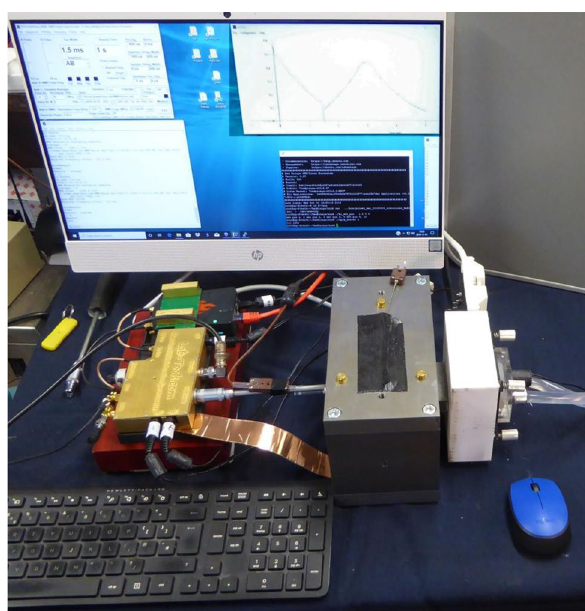
Fig. 9 A set of T 2 measurements using time-domain NMR which is sensitive to changes in the motion of the ice molecules in brittle ice, − 22C to